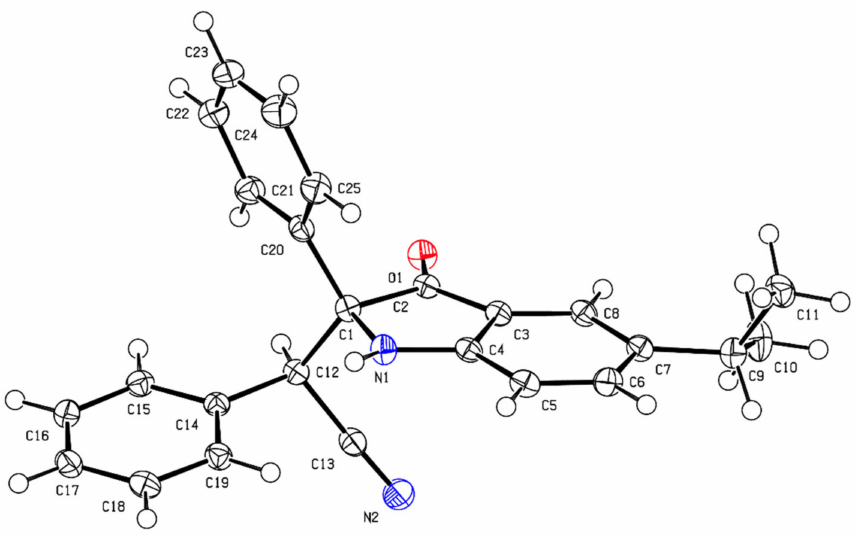
Figure 1. ORTEP drawing of X-Ray structures of 2-(5-isopropyl-3-oxo-2-phenylindolin-2-yl)-2- phenylacetonitrile ( 6ia , CCDC #2109943). The thermal ellipsoids are shown at 50%